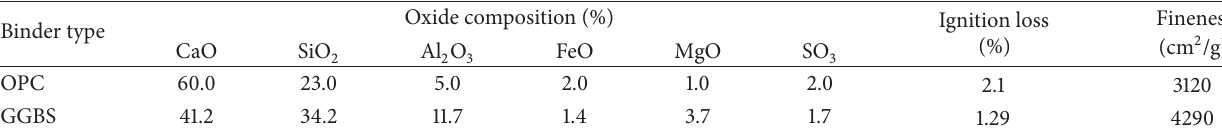
Table 1: Oxide composition of GGBS and OPC.